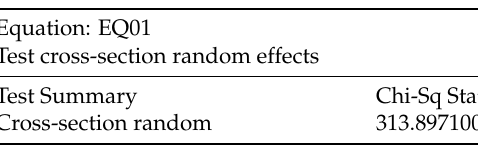
Table 7. Correlated Random Effects - Hausman